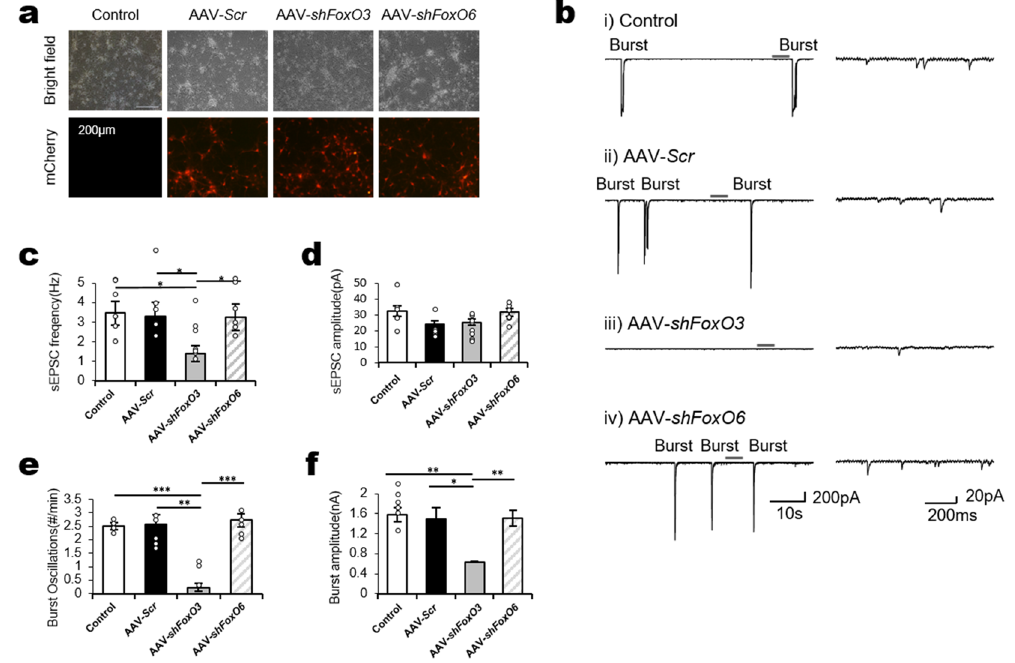
Figure 4. Knockdown of FoxO3 reduced sEPSCs, burst oscillations in mouse primary hippocampal neurons. ( a ) Primary hippocampal neurons without (control) or with infection of AAV- Scr , AAV- shFoxO3 , or AAV- shFoxO6 in bright-field (top) and mCherry fluorescence (bottom) images. AAV-infected groups had increased infection rates (38.1%, AAV- Scr ; 42.5%, AAV- shFoxO3 ; 56.7% AAV- shFoxO6 ). ( b ) Representative traces of sEPSCs and burst oscillations from primary hippocampal neurons held at − 70 mV in voltage clamping mode in the presence of picrotoxin. The part of each trace in the left panel marked with an upper line is enlarged in the right panel. ( c ) AAV- shFoxO3 neurons ( n = 8) exhibited fewer sEPSCs than control ( n = 6), AAV- Scr ( n = 6), or AAV-shFoxO6 ( n = 6) neurons. ( d ) There were no differences in sEPSC amplitude. ( e ) and ( f ) Burst oscillation frequency and amplitude were reduced in AAV- shFoxO3 neurons. * P < 0.05, ** p < 0.01, *** p < 0.001.